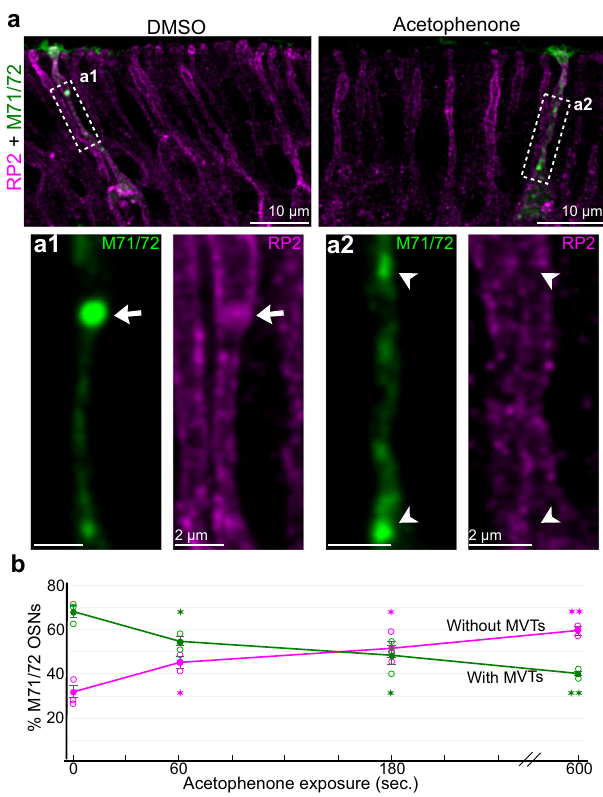
Fig. 8 | Odorant-evoked disintegration of the RP2 + -limiting membrane. a Double RP2 (magenta)/M71/72 (green) immunohistochemistry in OE obtained after exposure of awake and freely behaving mice to DMSO or acetophenone/ DMSOfor5min. a1 – a2 Close-upofareasoutlinedin( a ).AnintactMVT,i.e.RP2and M71/72 colocalization, is shown in ( a ), a1 (arrow). Two M71/72 + puncta that do not colocalize with RP2 are shown in ( a ), a2 (arrowheads). b Line graph showing the timecourseofpercentagedecreaseandincreaseof M71/72OSNswithandwithout MVTs after acetophenone exposure. For each time point 0, 60, 180 and 600s sample sizes were 420, 393, 421 and 381, respectively, from 3 mice in each group. The values represent mean±SEM. Two-sided unpaired Student ’ s t -test of data for 0s compared to each of the time points indicated in the plot (not adjusted for multiple comparisons),gave the following p values from left to right: 0.016, 0.018, 0.013 and 0.00068 for both curves. * p <0.05, ** p